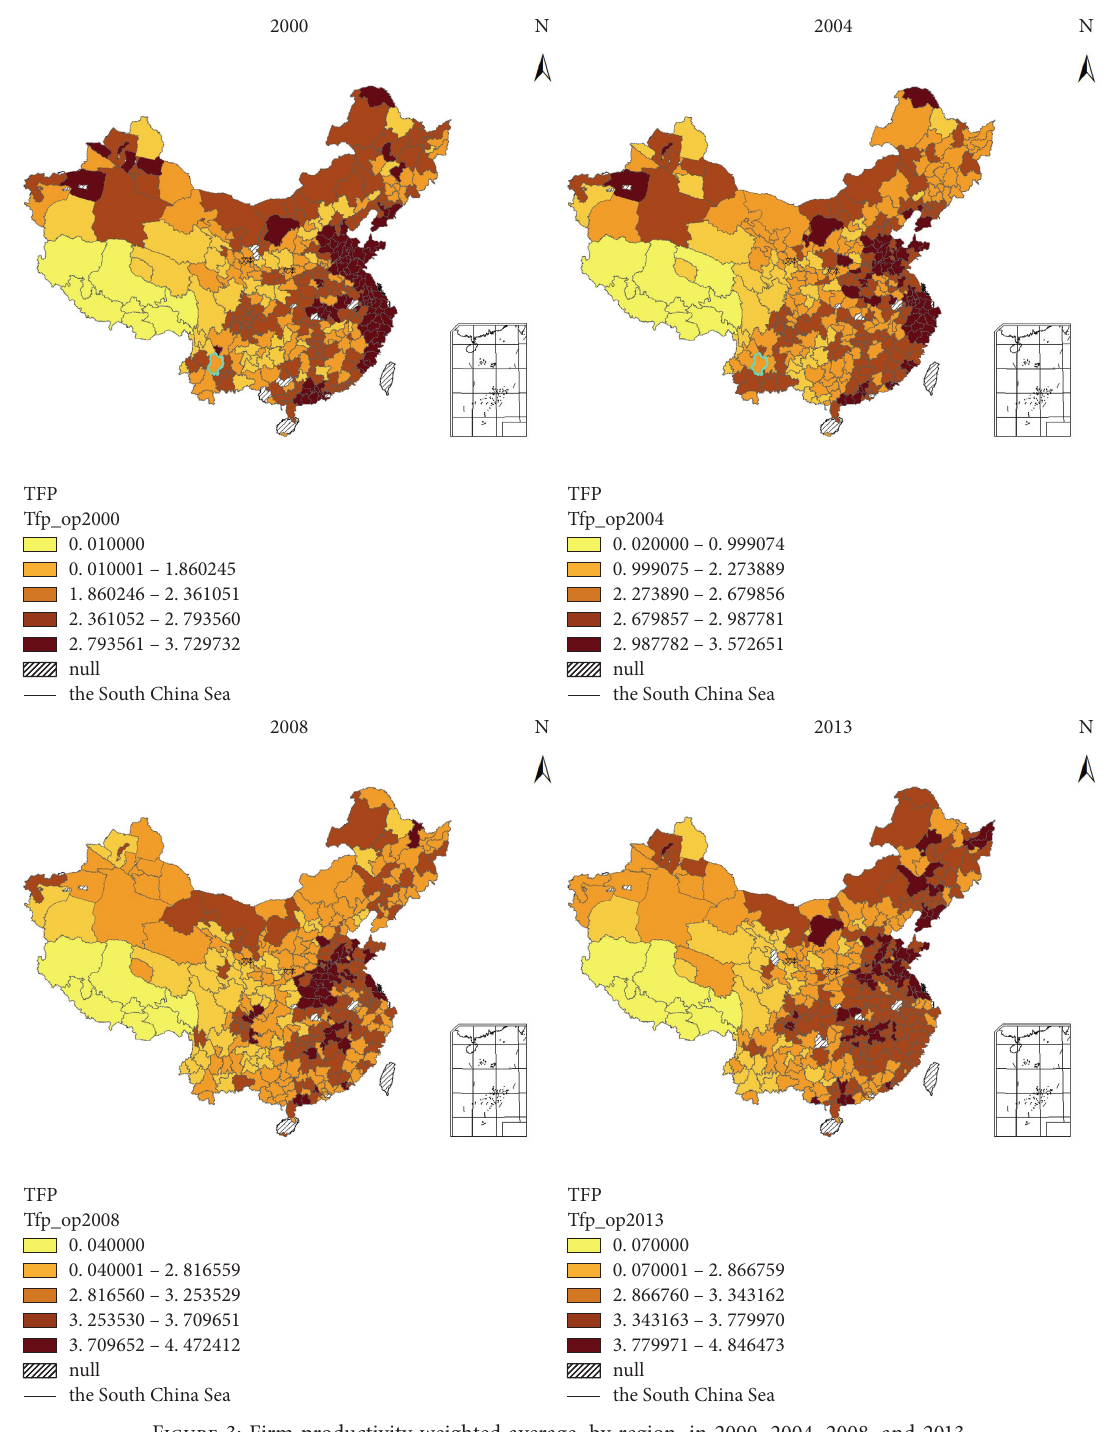
Figure 3: Firm productivity weighted average, by region, in 2000, 2004, 2008, and